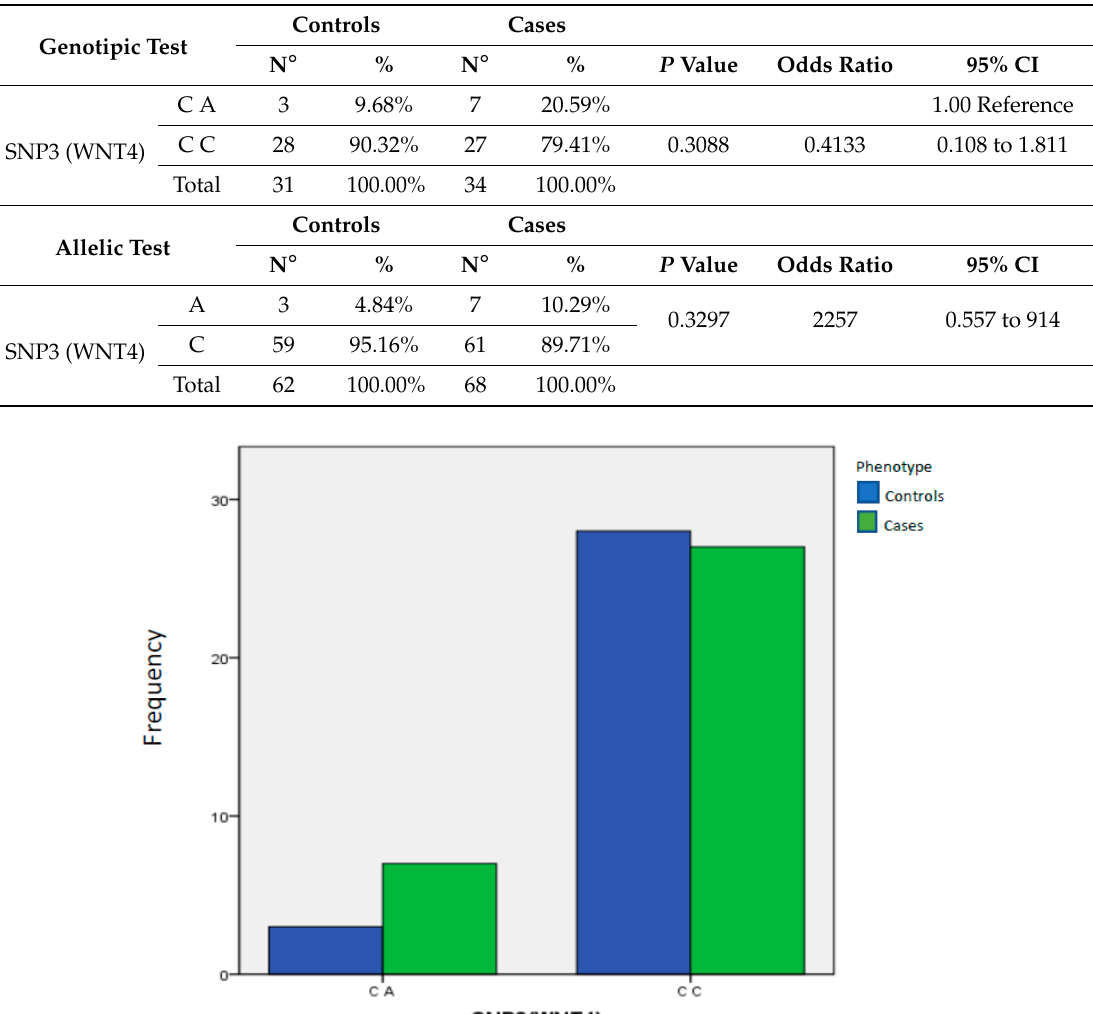
Figure 2. Distribution of AA, AC and CC genotypes obtained for polymorphism rs10859871 (VEZT). Table 7. Genotypic and allelic frequencies of rs7521902 (WNT4).